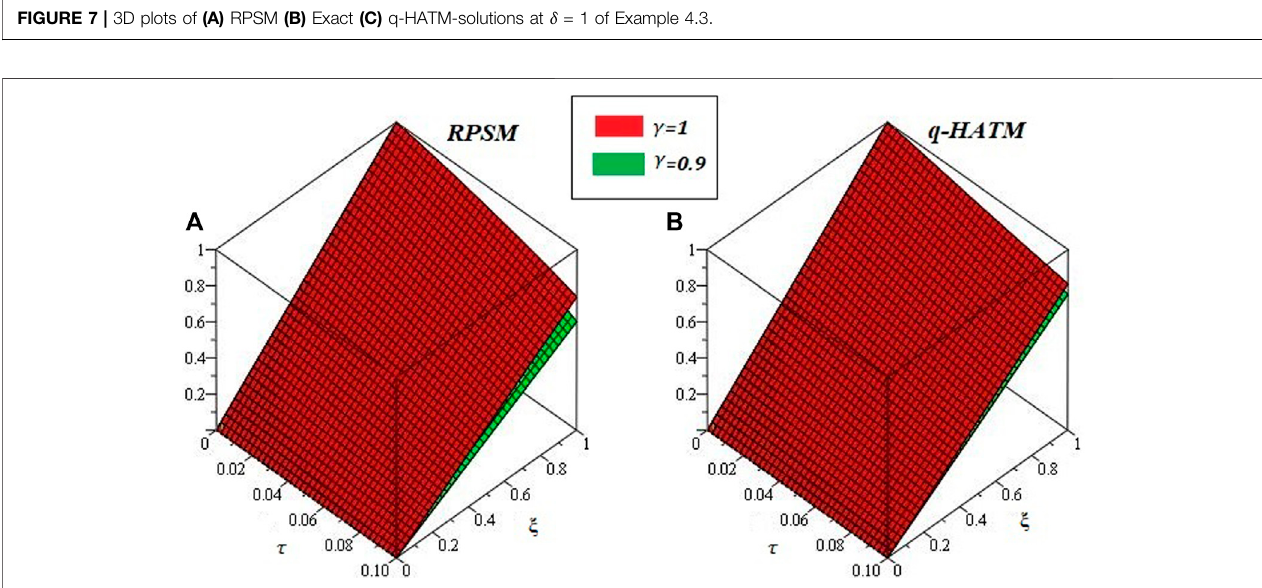
FIGURE 8 | 2D plots of (A) RPSM (B) Exact (C) q-HATM-solutions at δ = 1 of Example 4.3.